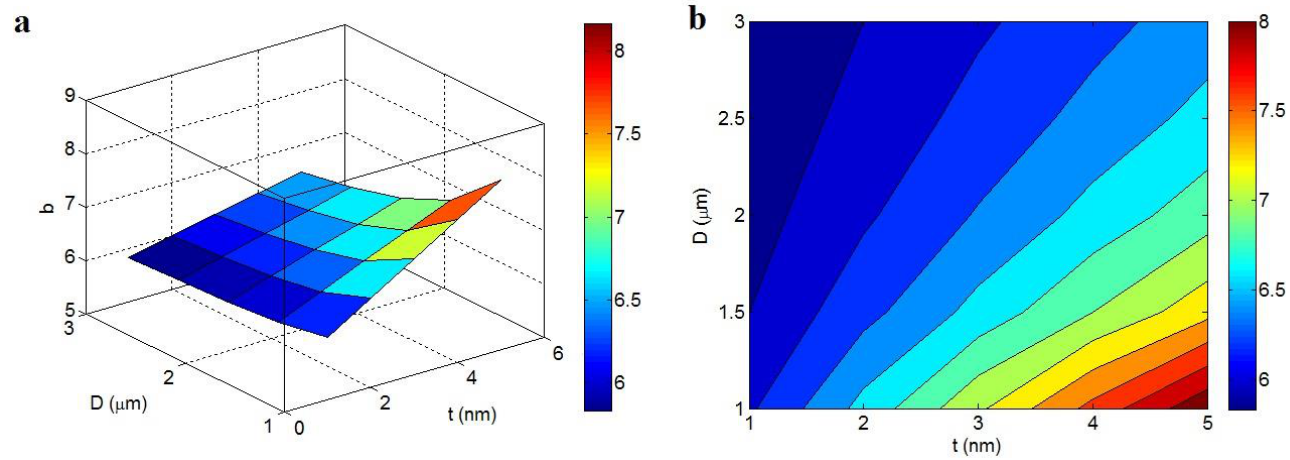
Figure 5. Dependencies of “b” exponent on “t” and “D” at t i = 4 nm, d = 5 nm and N = 10 by ( a ) 3D and ( b ) 2D charts.